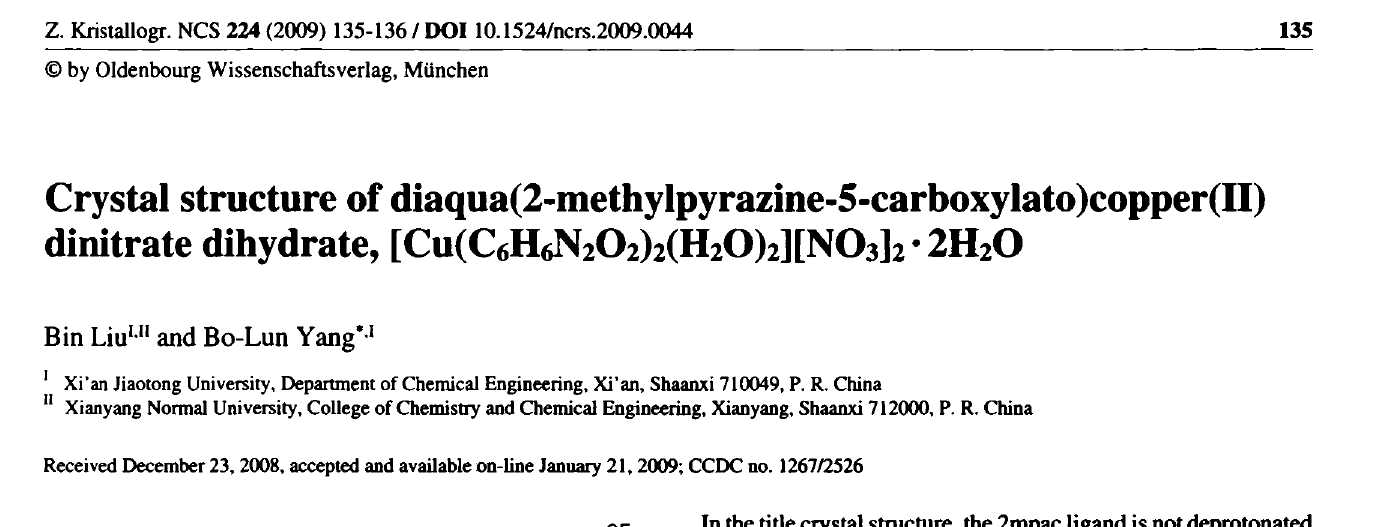
Table 1. Data collection and handling.